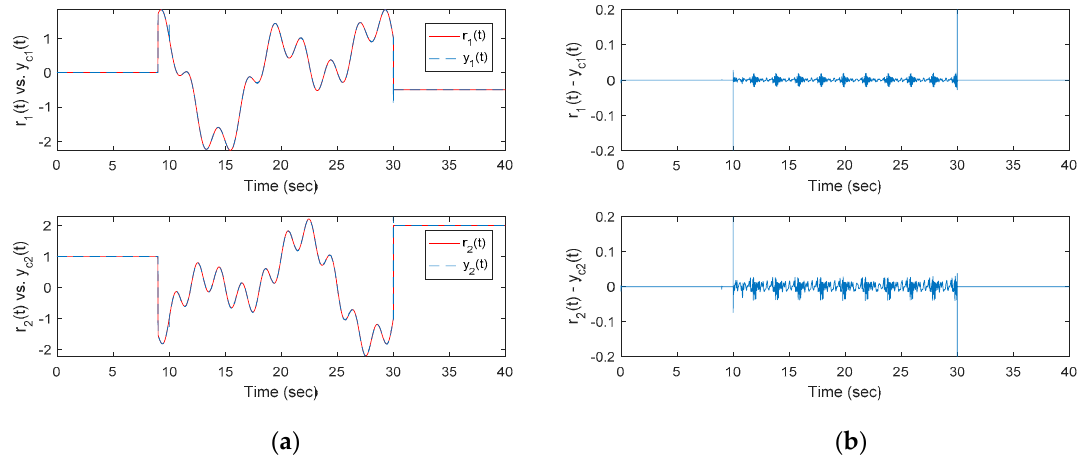
Figure 6. ( a ) Time responses of the proposed method and ( b ) errors of output e ( t ) = r ( t ) − y c ( t ) .